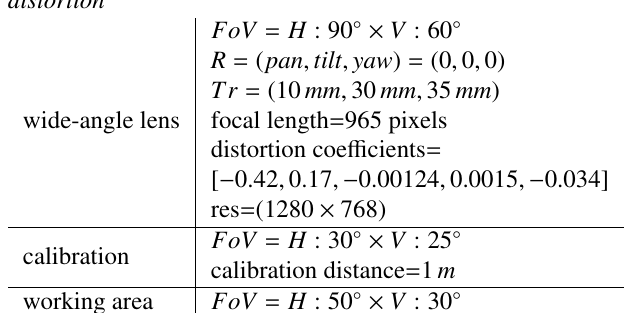
Parameters used in the simulation for testing the e ff ect of lens